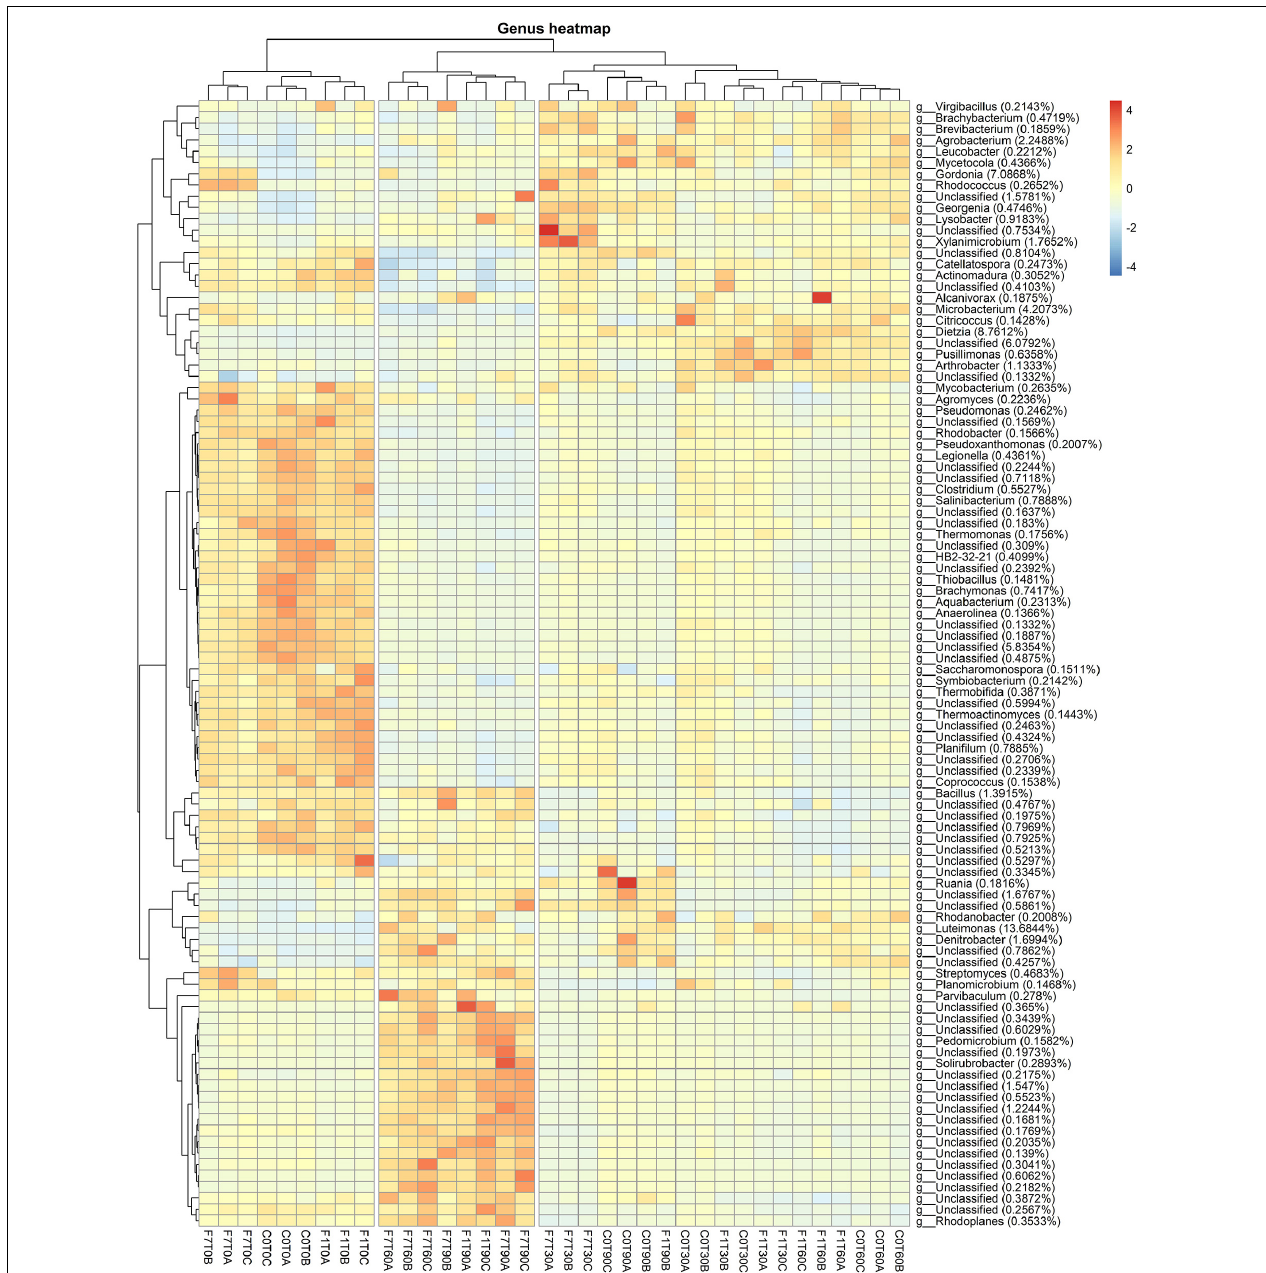
FIGURE 4 | Heatmap showing bacterial ASV abundances per sample at genus level with a cut-off of 0.01%. Hierarchical clustering was performed on both rows and columns by Pearson correlation, based on Euclidean distance. Color scheme represents row-wise Z-scores of ASV counts. Percentage reported near ASV names represent the relative abundance of the sum of ASV counts per sample against total sum (i.e., Z = 0 matches reported percentage).